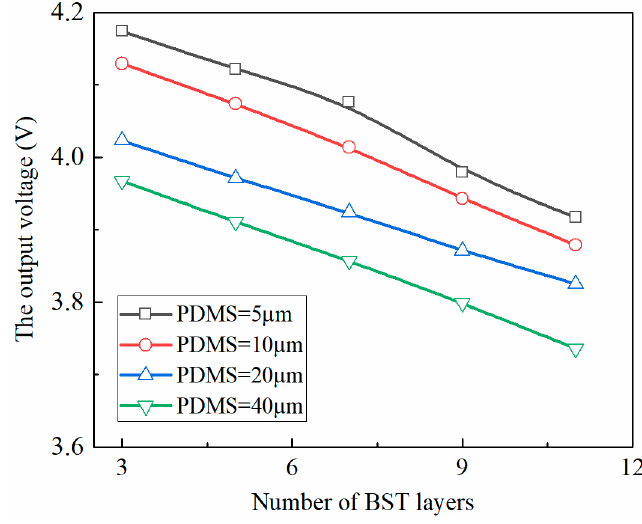
Figure 6. Optimal output voltage of multi-layer micro scale flexoelectric laminated beam energy collection device.